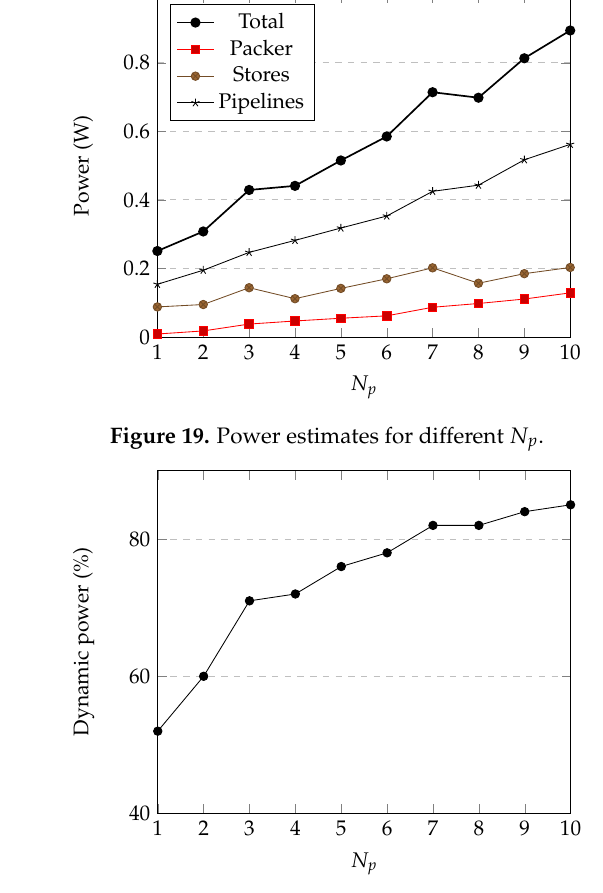
Figure 20. Dynamic power as percentage of total power